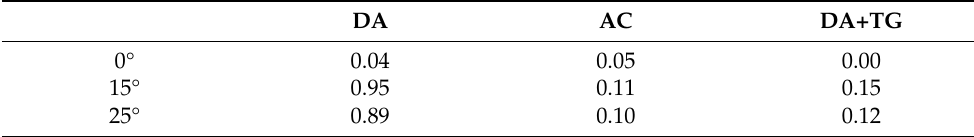
Table 1. Relative mean error ( (cid:101) RME ) calculated for the RCS measured at near-field distances corrected with F (in an AC or in a real site, after applying DA or a combination DA+TG), by taking as reference the RCS simulated at